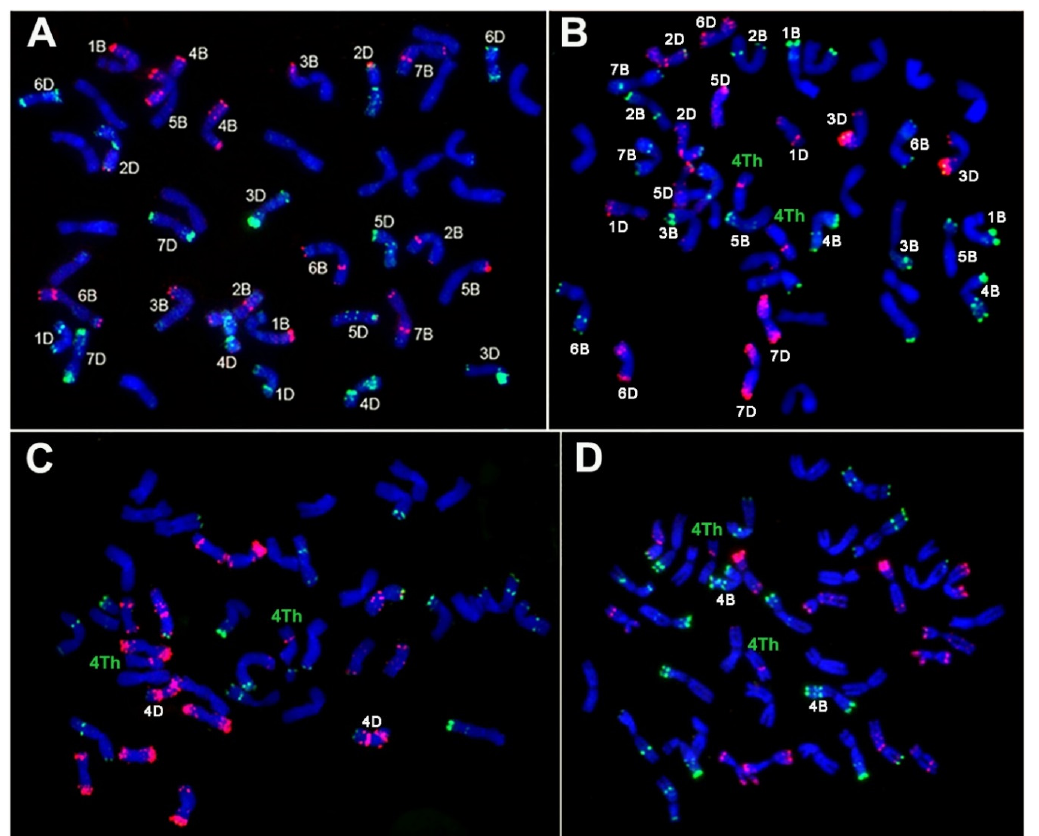
Figure 2. FISH with combinations of probes pSc119.2 and pAs1 specific to the mitotic metaphase chromosomes of T. aestivum cv. Saratovskaya 29 (S29) (parental line) ( A ), cv. Meropa ( B ), black ‐ grained line s:S29 Ba1 4Th(4B) Pp3 P Pp ‐ D1 PF with long trichomes on leaves ( C ), and black ‐ grained line s:S29 Ba1 4Th(4D) Pp3 P Pp ‐ D1 PF with leaves like those of cv. S29 ( D ). pSc119.2 (red) and pAs1 (green) are presented in ( A ); pSc119.2 (green) and pAs1 (red) are presented in ( B – D ). Cryosections of seeds of red ‐ grained cv . S29, of purple ‐ grained NIL